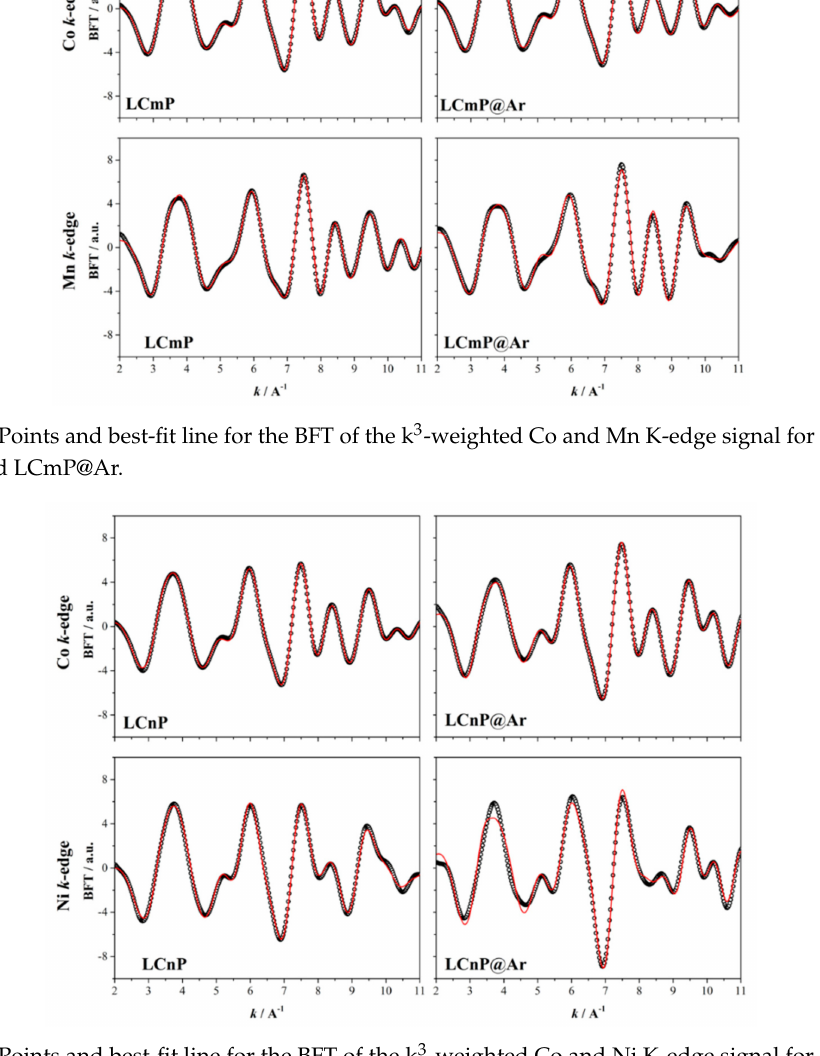
Figure 6. Points and best-fit line for the BFT of the k 3 -weighted Co and Ni K-edge signal for samples LCnP and